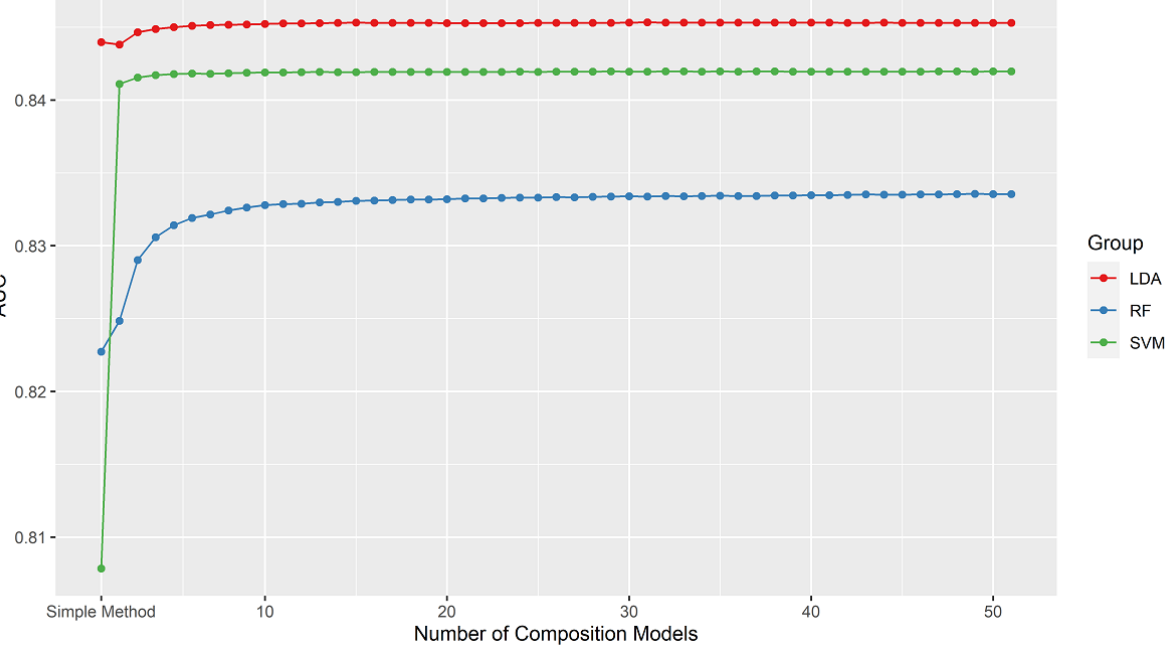
Figure 2. Comparison of the top 50 models with the easy ensemble method and the simple method with different machine learning methods and